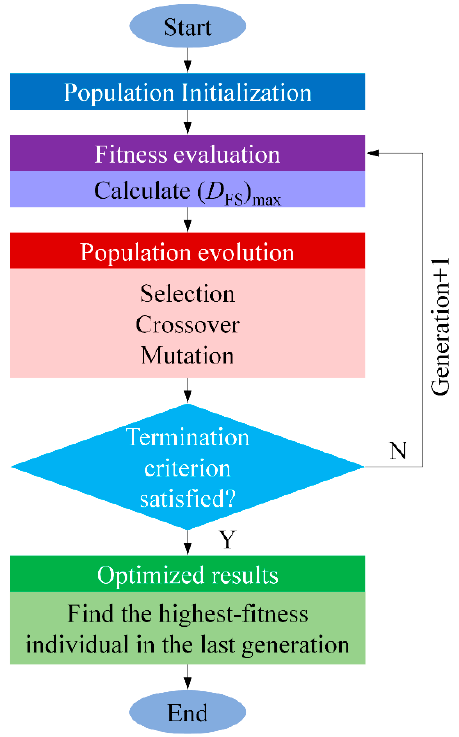
Figure 5. Basic steps in the genetic algorithm (GA). Table 2. Parameters of the genetic algorithm.